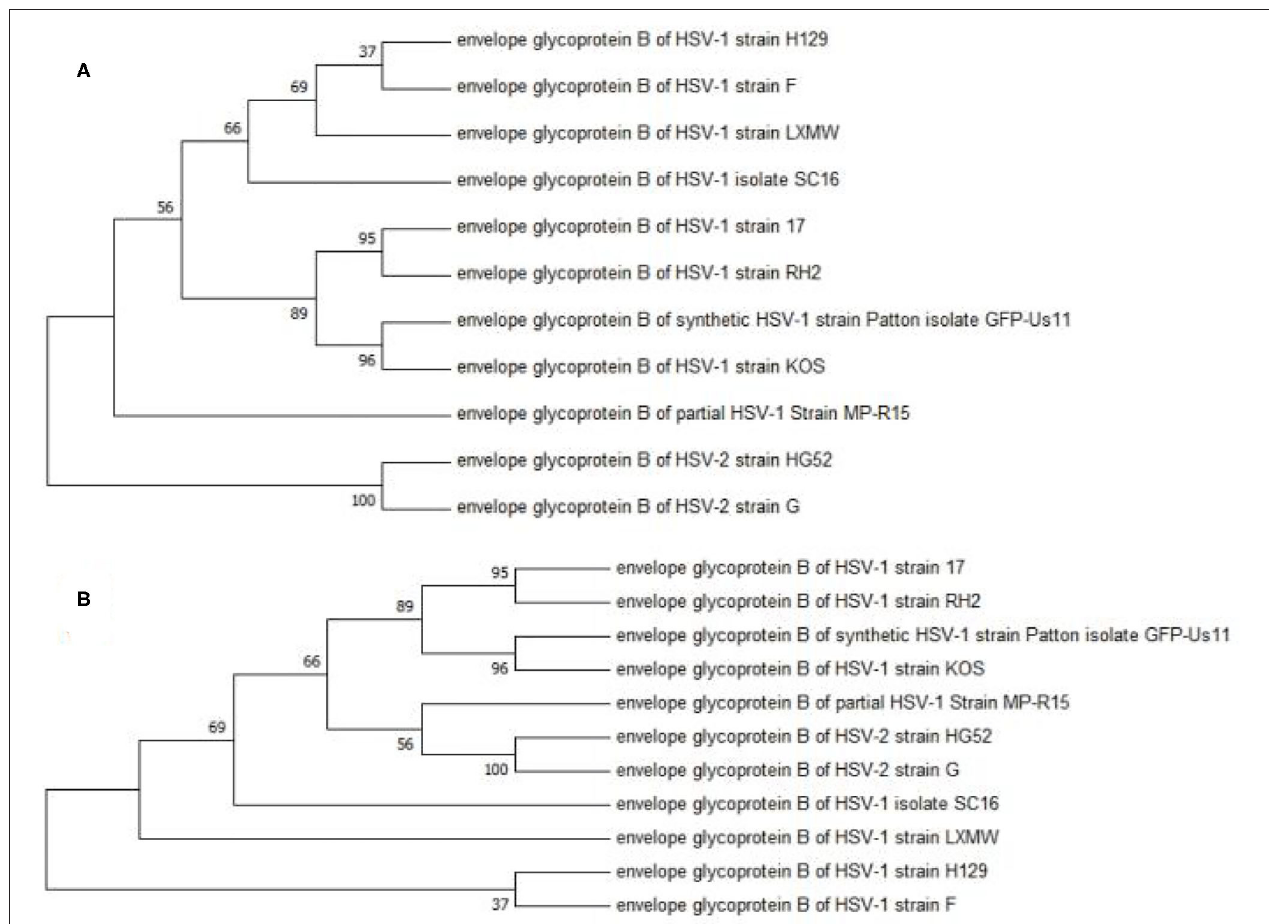
FIGURE 1 | Phylogenetic analysis of the gBs of 11 HSV strains. This phylogenetic tree was generated by the neighbor-joining (NJ) method using MEGA7. The percentage of trees in which the associated taxa were clustered together is displayed next to the branches. The cladogram with the highest log likelihood is displayed. (A) The evolutionary tree is drawn to scale, with branch lengths measured in number of substitutions per site. (B) The bootstrap consensus tree is taken to represent the evolutionary history of the taxa analyzed. Our result showed an average distance of about 69% among the